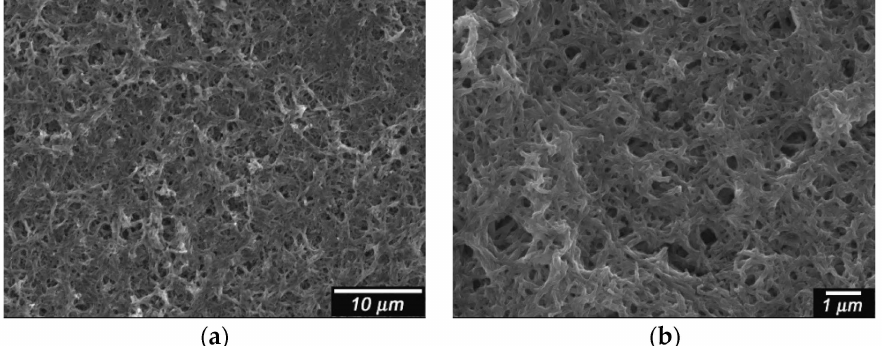
Figure 3. Scanning electron microscope (SEM) images of PANI/( ´ )-CSA. CSA = camphor sulfonic acid. ( a ) Low magnification; ( b ) High